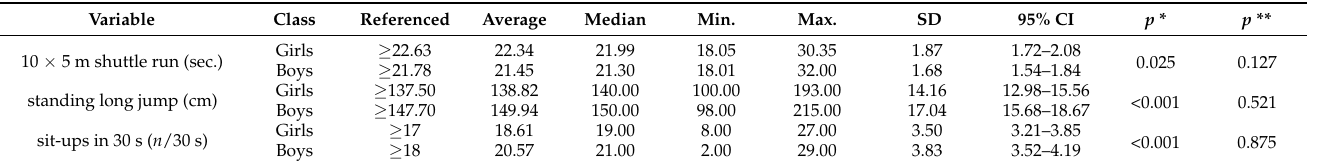
Table 5. Averaged fitness test results from the initial and final measurement sessions in a group of girls and